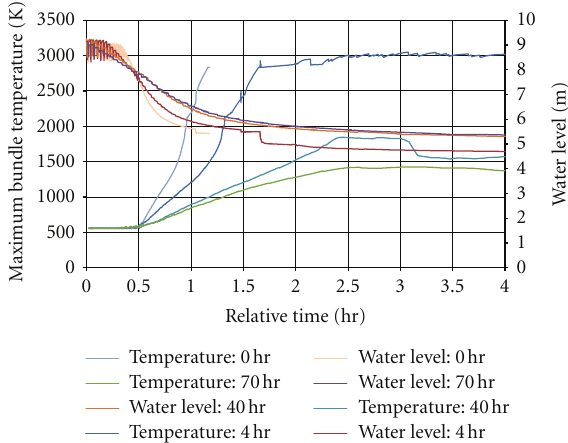
Figure 26: Maximum bundle temperature and water level for high-pressure scenarios for scenarios where all of the emergency water injection was terminated at a time varying from 0 hours to 70 hours after scram.